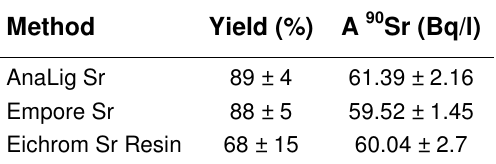
Radiochemical Yield and Activity Determined of Model Solution - 59 Bq/l 90 Sr (18